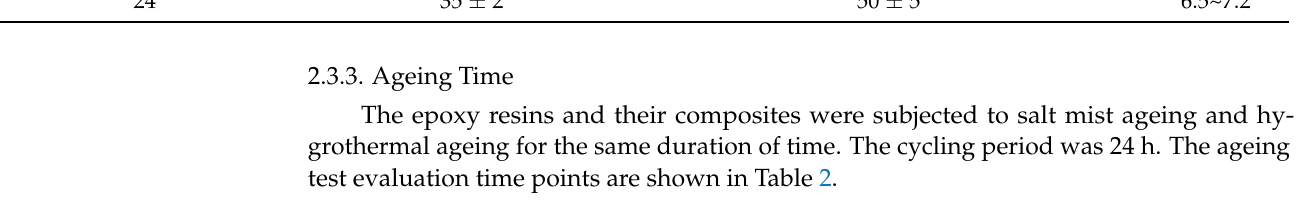
Table 2. Ageing test evaluation time points.